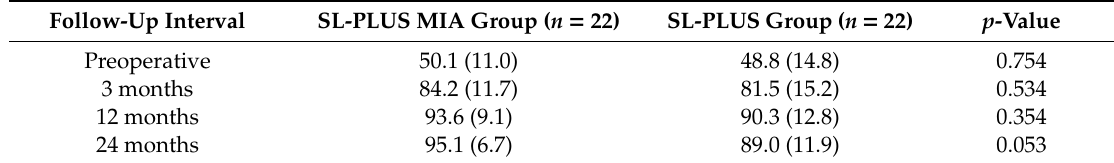
Table 4. Summary of the clinical results as measured with the Harris Hip